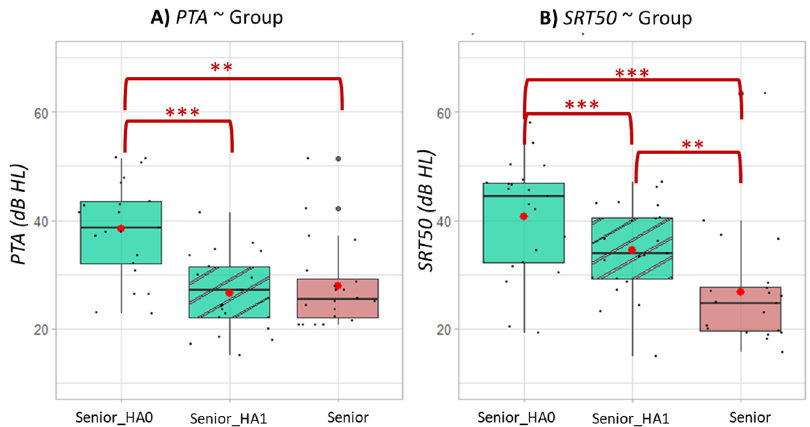
Figure 2. Hearing scores ( A ) for PTA and ( B ) for SRT50 as a function of group. Senior_HA0 represents the group Senior_HA when participants did not wear their hearing aids. Senior_HA1 represents the group Senior_HA when participants were wearing their hearing aids. Senior represents participants the group Senior. Asterisks indicate Wilcoxon test p values less than 0.05: ‘**’ for 0.001 < p < 0.01; ‘***’ for p < 0.001.